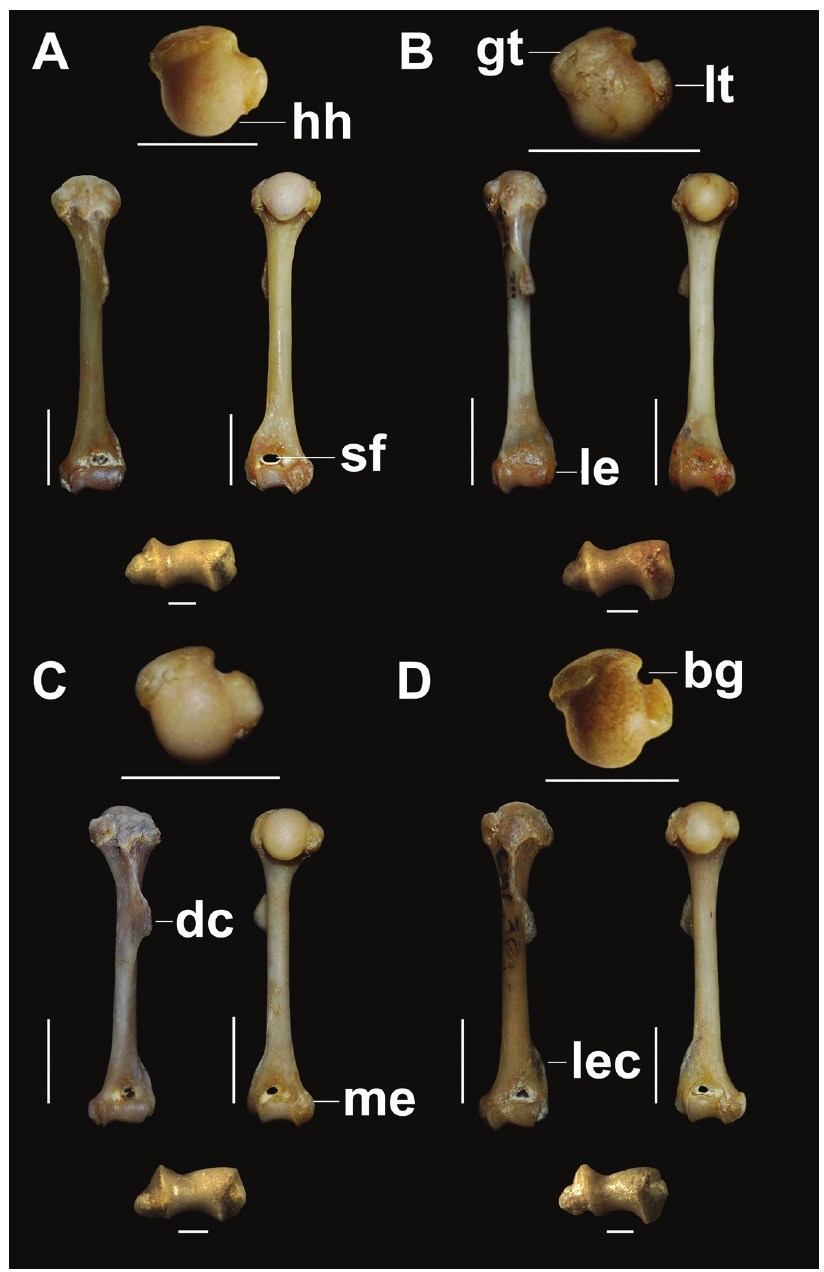
Figure 2. Left humerus, proximal, anterior, posterior, and distal views. A Tympanoctomys aureus B Tym- panoctomys barrerae C Tympanoctomys kirchnerorum D Tympanoctomys loschalchalerosorum . bg, bicipital groove; dc, deltoid crest; gt, greater tuberosity; hh, humeral head; le, lateral epicondyle; lec, lateral epicon- dylar crest; lt, lesser tuberosity; me, medial epicondyle; sf, supratrochlear foramen. Scale bars 5 mm for all views except distal view where the scale bars are 1